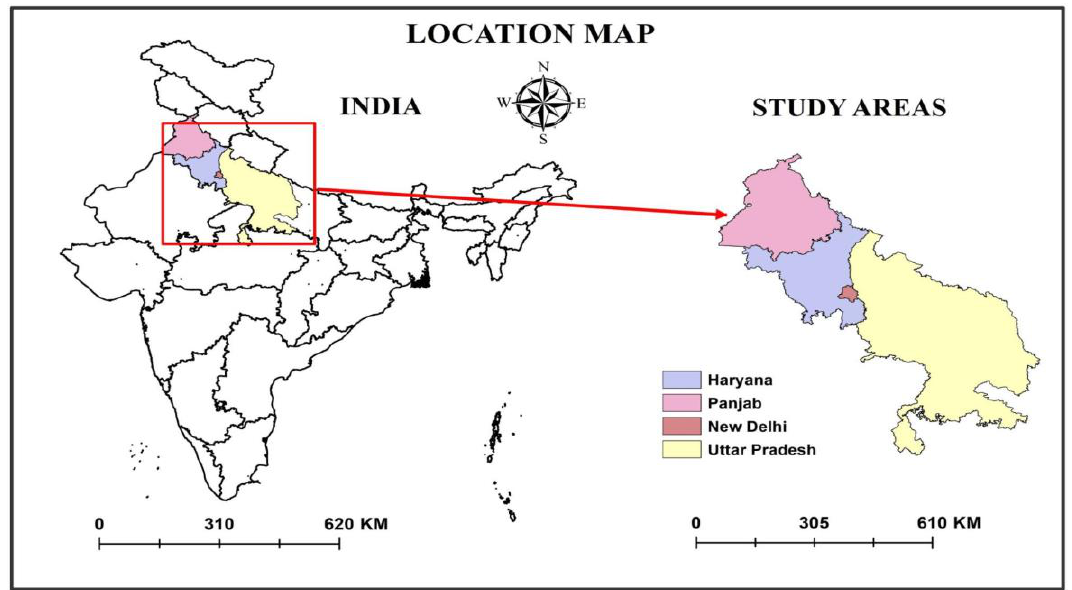
Figure 1. Location map of the study sites: Haryana, Punjab, New Delhi, and Uttar Pradesh.